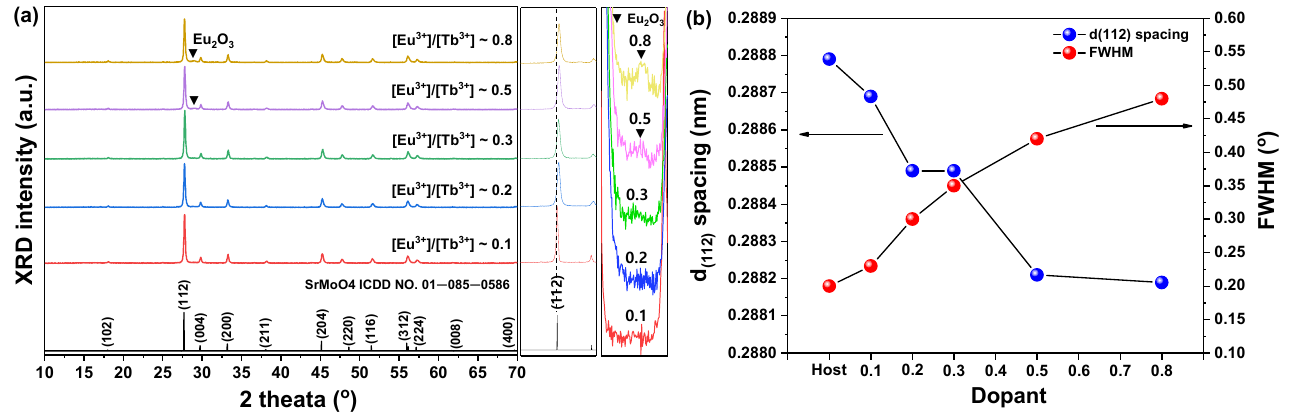
Figure 5. ( a ) XRD patterns of SrMoO 4 :[Eu 3+ ]/[Tb 3+ ], ( b ) change of d (112) spacing and FWHM according to Eu 3+ ion.